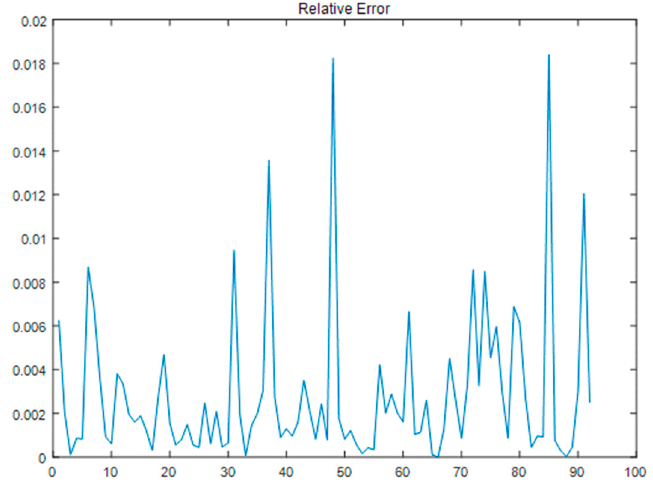
Figure A4. Relative error variation of Wannian community.